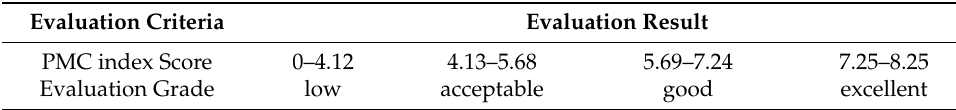
Table 2. Policy evaluation criteria based on PMC